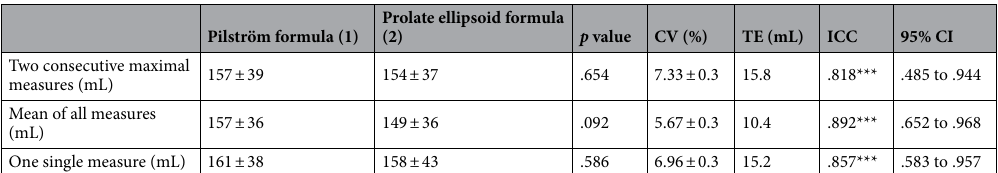
Table 3. Comparisons of different methods of establishing baseline splenic volume (Mean ± SD) between Pilström and Conventional formulas with corresponding reliability measures. *** p < .001. Values refer to comparisons of test